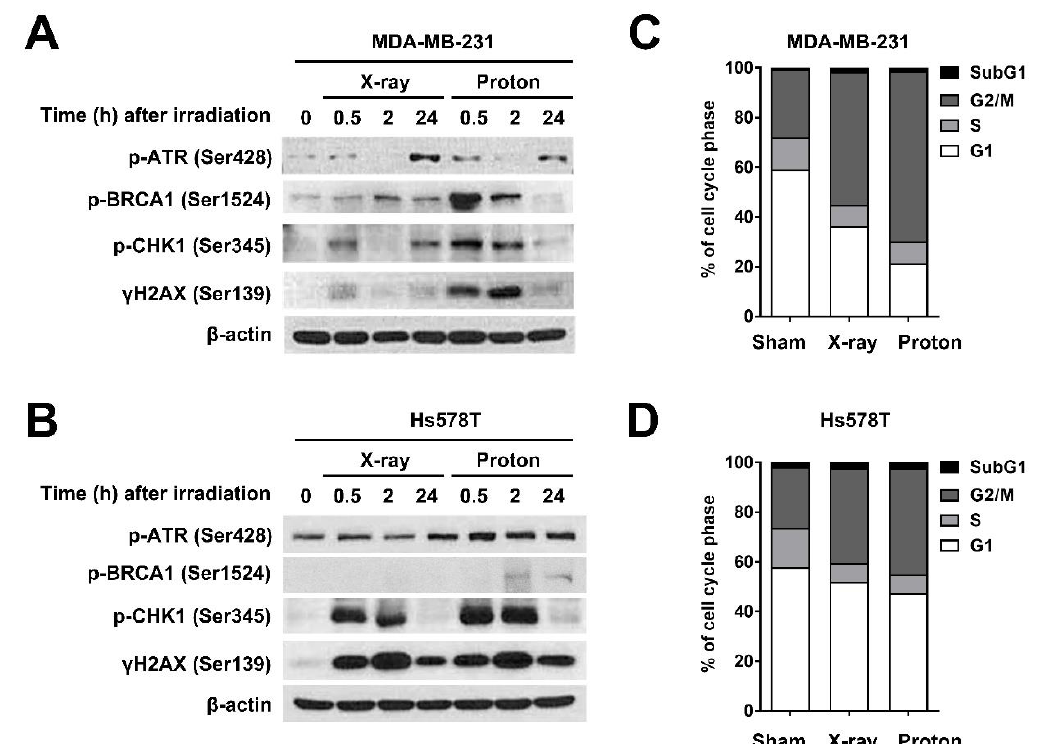
Figure 1. Di ff erential checkpoint kinase 1 (CHK1) activation and cell cycle redistribution in response to irradiation with X-rays and protons in human triple-negative breast cancer (TNBC) cells. Western blotting showed di ff erential activation of ataxia telangiectasia and rad3-related (ATR) / CHK1 signaling in response to X-ray and proton irradiation in MDA-MB-231 cells ( A ) and Hs578T cells ( B ). Cells were harvested at the indicated times after irradiation with 4 Gy of X-rays or protons. β -actin was used as a loading control. Cell-cycle distribution in MDA-MB-231 cells ( C ) and Hs578T ( D ) after irradiation with 4 Gy of X-rays or protons. Cells were harvested 24 h post-irradiation and subjected to flow cytometry.